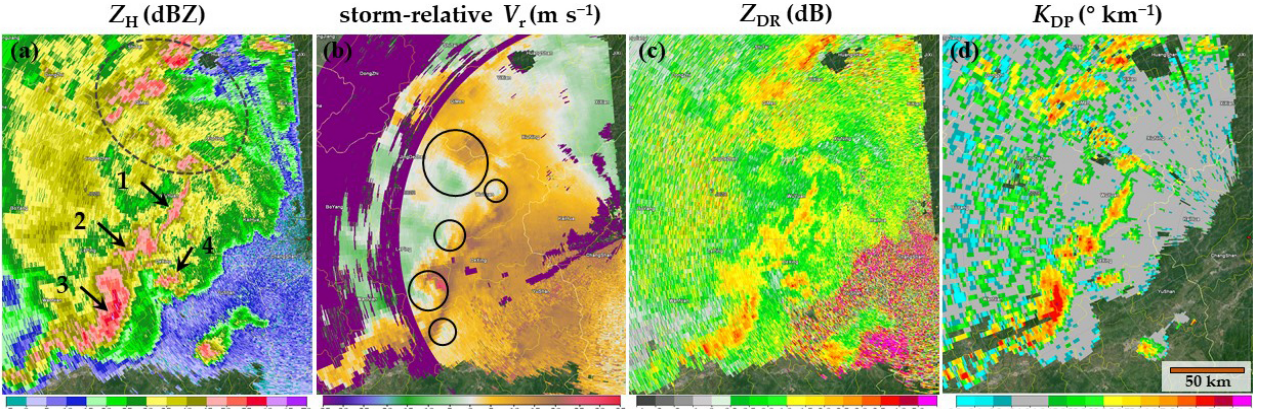
Figure 6. Composite PPIs of ( a ) Z H , ( b ) storm-relative V r , ( c ) Z DR , and ( d ) K DP at an elevation angle of 0.5°, as observed by QZ-SPOL data at 2013 BT on 10 May 2021. Arrows point to the storm cells on the reflectivity panels. Vortices are circled in black on the velocity panels.